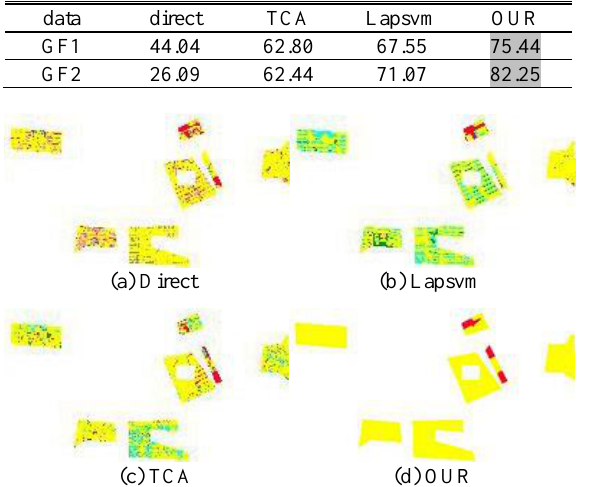
Table I Classification accuracy of the 2 GF data sets.